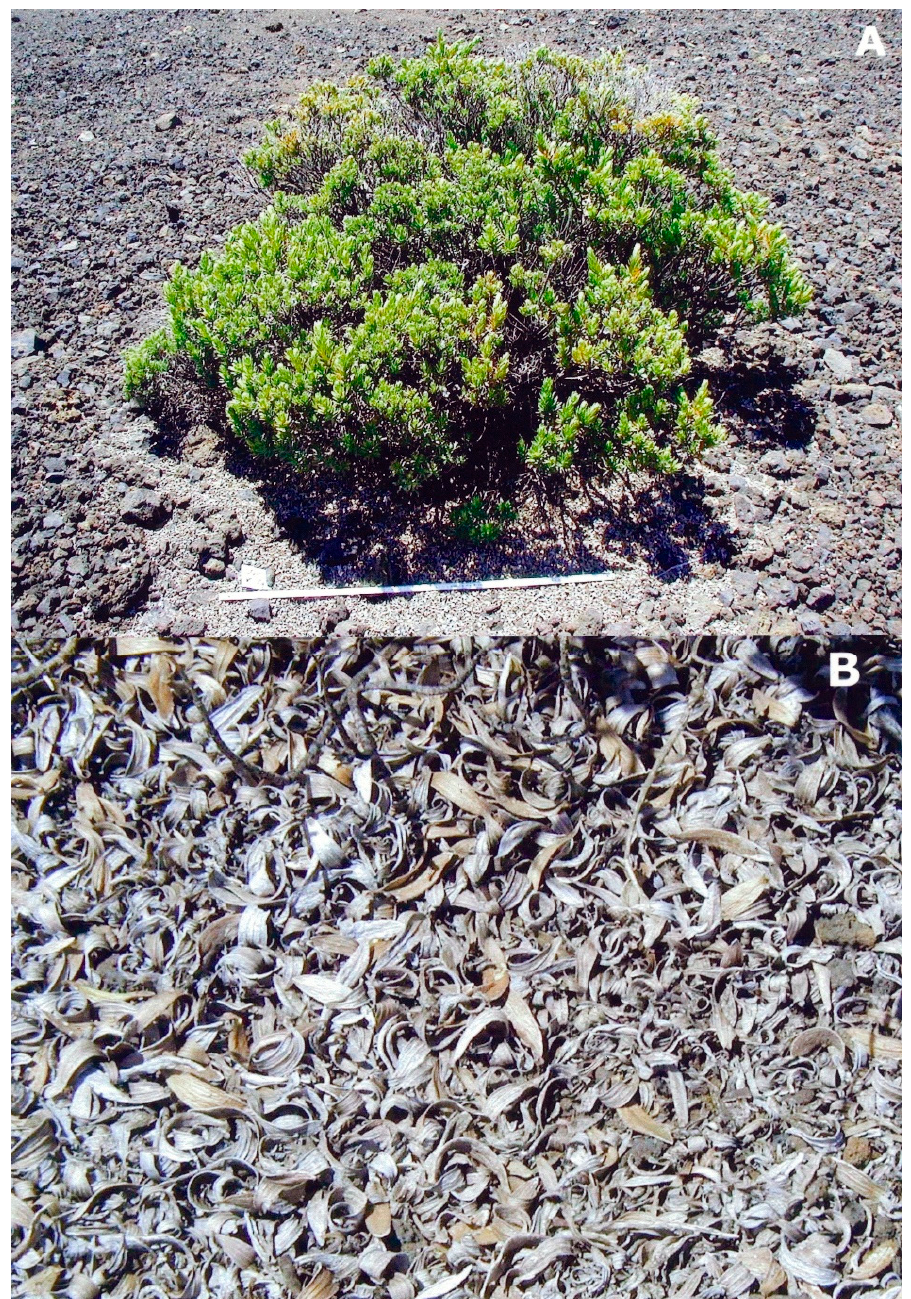
Figure 4. ( A ) Large k ū paoa shrub, ~152 cm tall, ~230 cm wide, at ~2635 m on a 23° slope; upslope is toward the top. Note the prominent cover of light-gray foliage litter forming the litter island (LI)—which essentially coincides with the plant’s width—under the shrub canopy and downslope from it; maximum litter depth near the shrub stem was 73 mm. This slope is mantled with block- and cobble-sized tephra and cinder; white scale is 100 cm long. Photo: Hk-375-05, 24 July 2005. ( B ) Surface view of k ū paoa leaf litter on a LI under a ~114-cm tall shrub, ~2690 m, on a 24° slope. Area shown is ~40 × 30 cm; litter depth was ~35 mm. Photo: Hk-94-05, 20 July